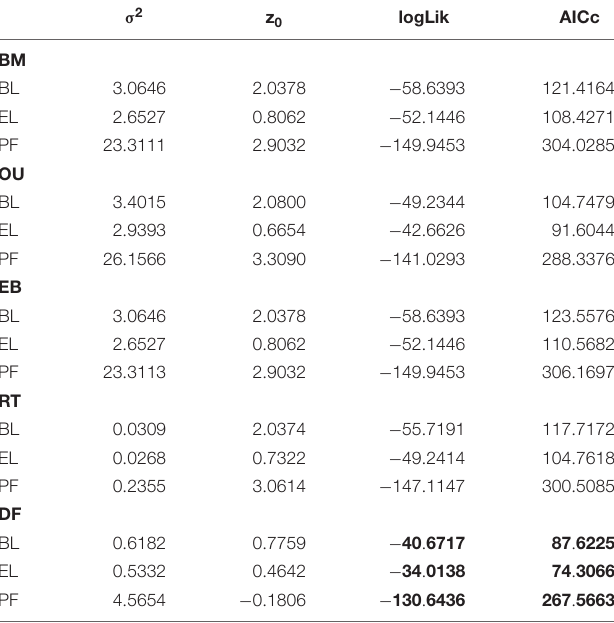
TABLE 4 | Parameters of fitContinuos models for body length (BL), egg length (EL), and potential fecundity (PF) of